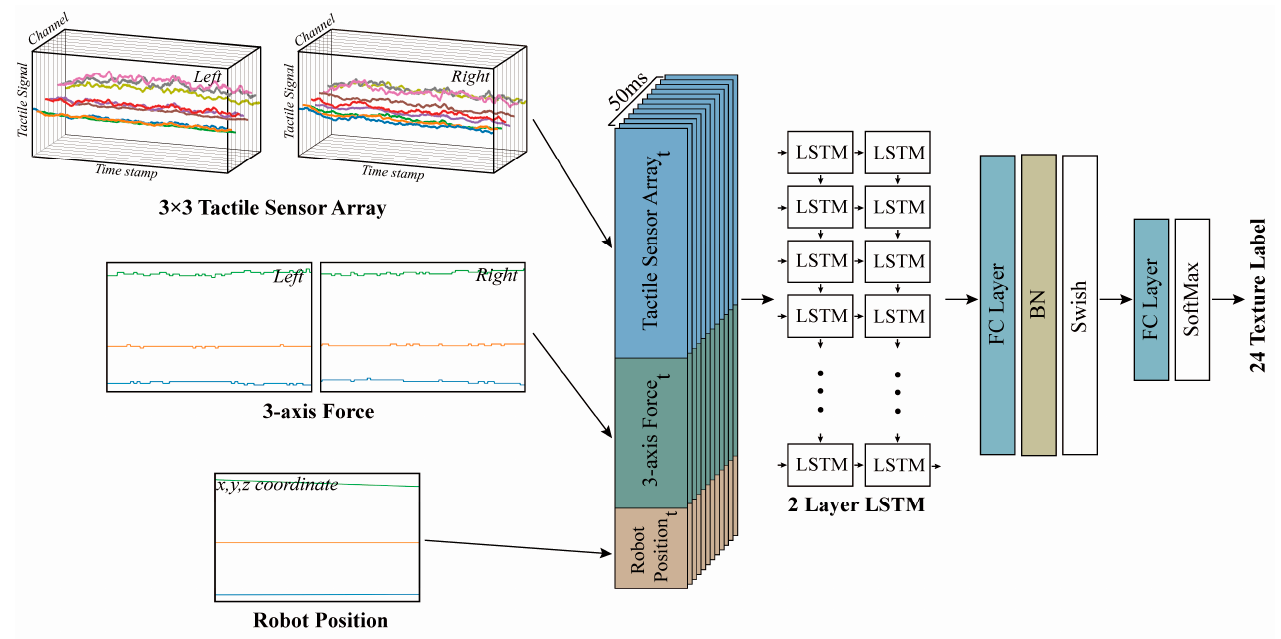
Figure 4. Neural network architecture used for the classification of 24 textures. The input to the network consists of 3 × 3 tactile sensor arrays (left and right), 3-axis force data (left and right), and robot position information. Sequence data cropped at 50 ms intervals (window length) are concatenated and fed into the LSTM layer. The 64 features generated from the two LSTM layers are finally processed through a fully connected layer (FC layer), resulting in the classification of 24 textures.